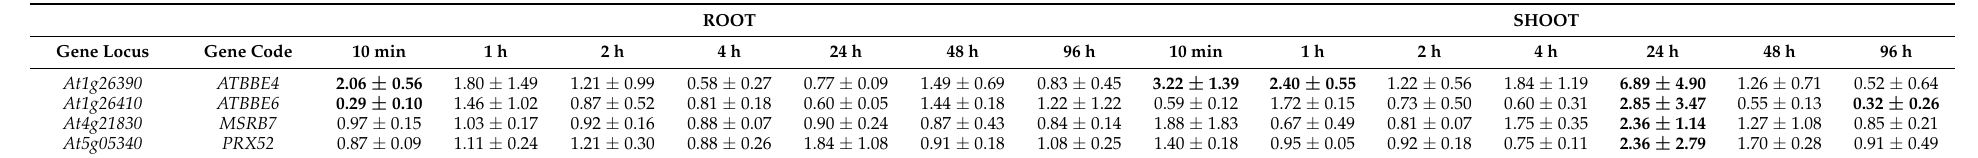
Table 3. Group C. Genes characterized by a strong upregulation in shoots at 24 h. Genes were selected based on a fold change ≥ 2 or ≤ 0.5 in at least one time point. Values are expressed as the mean and standard deviation ( ± ), values with a fold change ≥ 2 or ≤ 0.5 are indicated as boldfaced numbers. ROOT